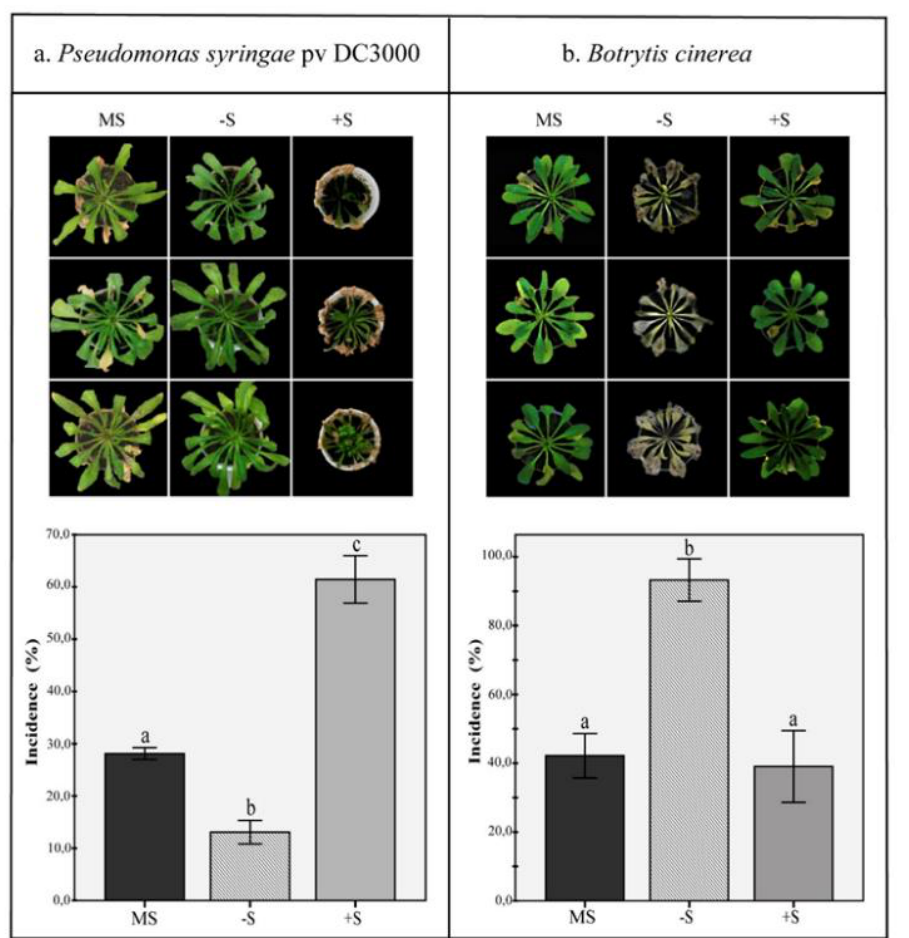
Figure 6. Disease development in ( a ) Arabidopsis thaliana wild-type (Col-0) after seven days of inoculation with Pseudomonas syringae pv. DC3000 and ( b ) A. thaliana pad3 mutant after seven days of inoculation with Botrytis cinerea . Plants were treated with MS standard sulfur concentration (MS), sulfur deficiency (-S), and sulfur excess (+S). Disease symptoms are depicted in the upper panel, and the incidence is presented in the lower panel. The bars represent the mean of three independent replicates. Error bars indicate a standard deviation. Bars sharing the same letter are not significantly different ( p < 0.05) determined by single-factor ANOVA with Tukey’s HSD test.